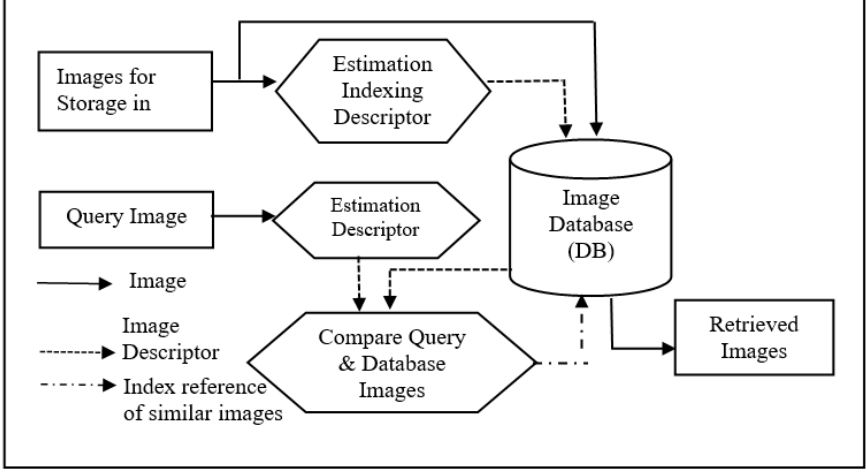
Figure 1. General Architecture of CBIR System.